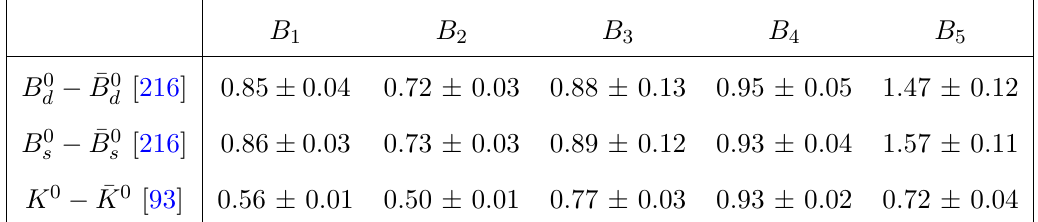
Table 13 . Bag parameters for B q (cid:0) (cid:22) B q and K 0 (cid:0) (cid:22) K 0 oscillations, in the MS scheme. For B q (cid:0) (cid:22) B